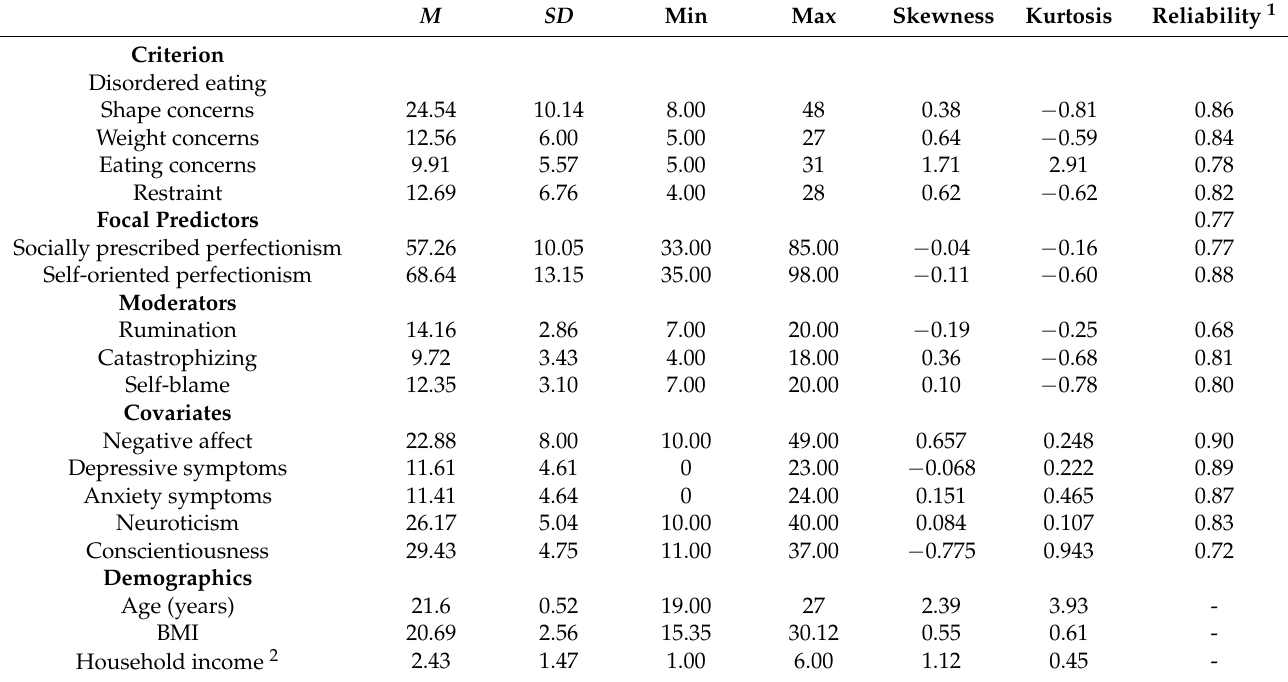
Table 1. Descriptive statistics of predictors, covariates, and criterion